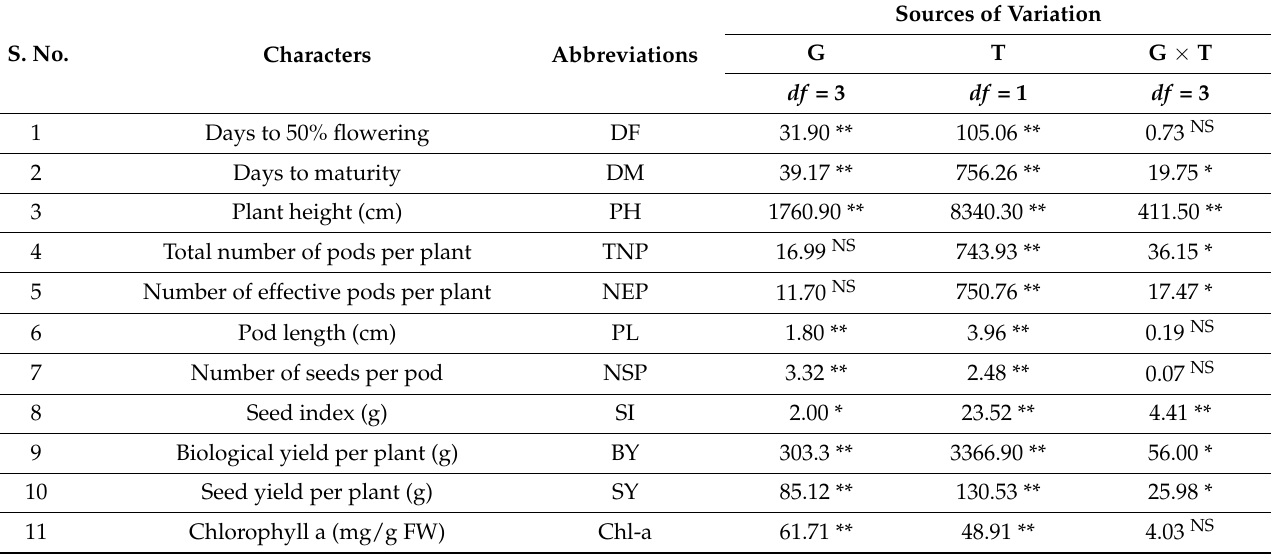
Table 1. Mean sum of squares for morphological, physiological, and biochemical traits of four field pea